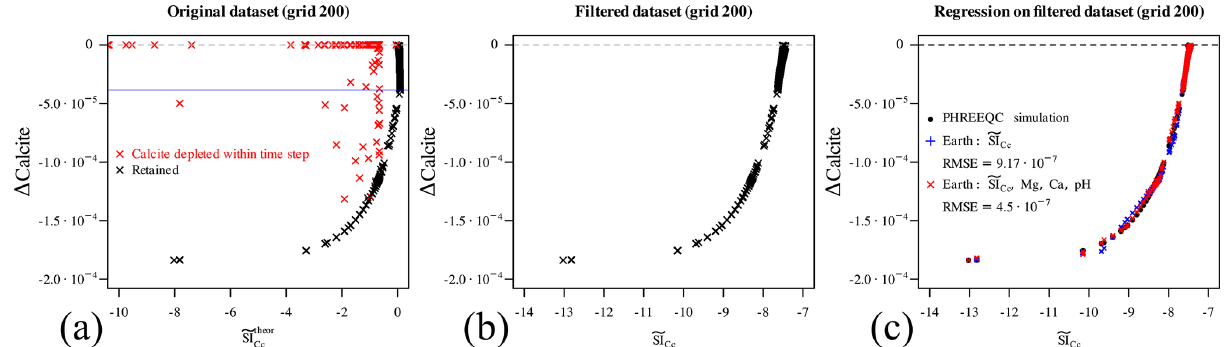
Figure 5. (a) Scatter plot of (cid:49) calcite vs. estimated (cid:101) SI theor Cc . The data points in red cannot be used to estimate the reaction rate from the dataset since calcite is depleted within the simulation time step. Furthermore, the retained points are not in a bijective relationship with the (cid:49) calcite, with the blue horizontal line separating two regions where bijectivity is given. (b) (cid:49) calcite versus the simplified (cid:101) SI Cc : bijectivity is achieved. (c) A MARS regressor is computed for the retained data points based solely on the estimated (cid:101) SI Cc (in blue) and also using other predictors to ameliorate the multivariate regression.